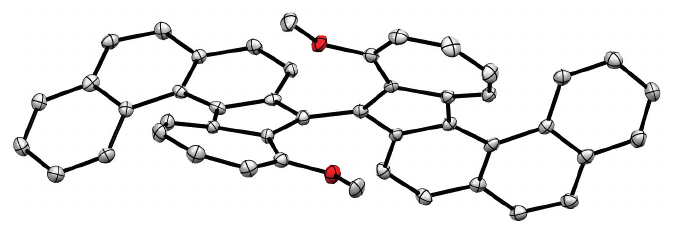
Figure 1. ORTEP drawing of the X-ray crystal structure of 2 . Dichloromethane and H-atoms have been omitted for